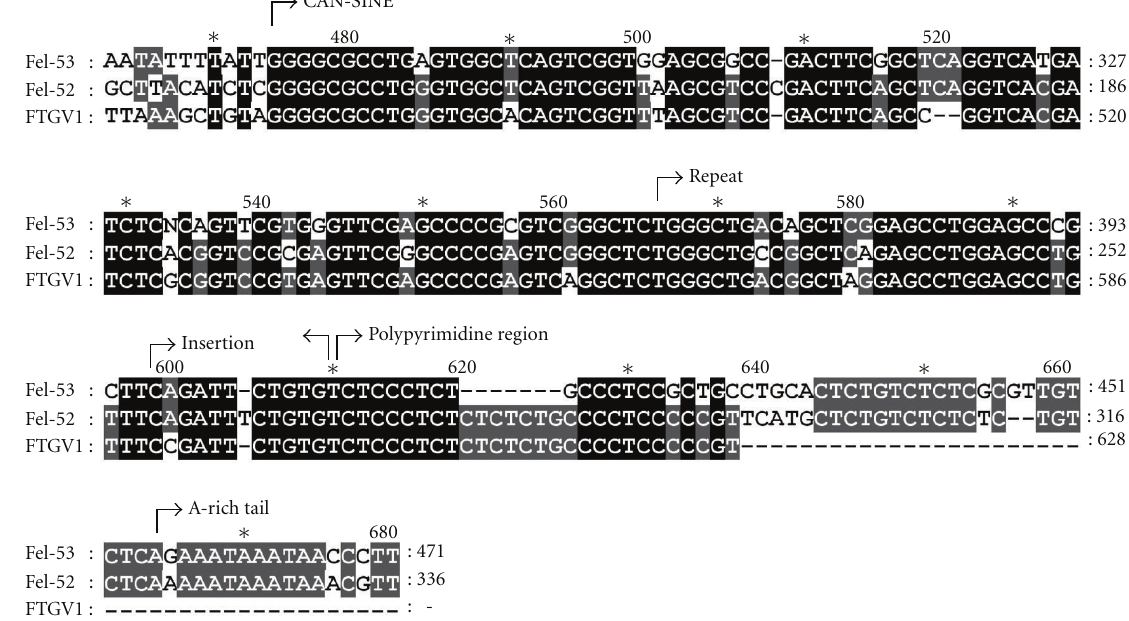
Figure 4: Alignment of the CAN-SINE amplified by a SMART RACE procedure with typical CAN-SINES of cats. The clone FTGV1 is depicted as a complementary strand in relation to the TRG genes. The CAN-SINE has an insertion prior to the polypyrimidine region and a direct repeat after the tRNA-related part that are typical in feline CAN-SINEs [14].